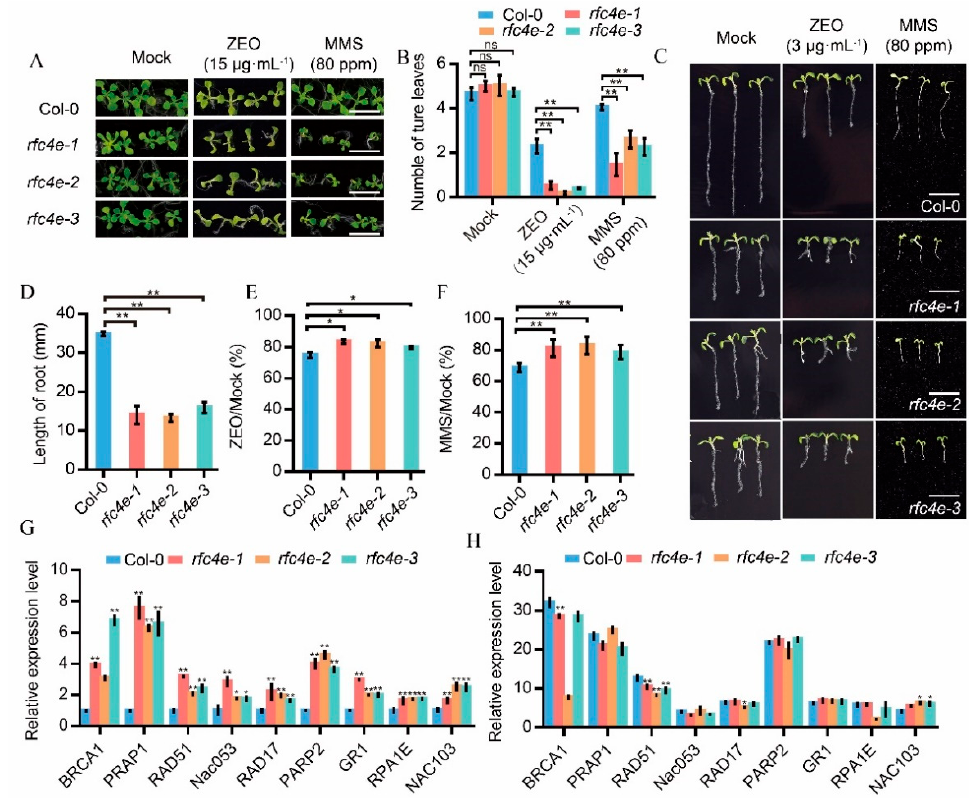
Figure 5. The rfc4e mutants were sensitive to DNA damage agents and constitutively expressed DNA repair-related genes. ( A ) The 12 − d − old seedling of rfc4e − 1 , rfc4e − 2, rfc4e − 3 and Col − 0 grown on ½ MS medium containing 80 ppm MMS or 15 μ g·mL − 1 Zeocin. Mock, treatment without MMS and Zeocin used as control. Bar = 1 cm. ( B ) Average numbers of true leaves of the indicated genotypes in ( A ). Error bars indicate ± SD, n = 39. ( C ) Roots of rfc4e − 1 , rfc4e − 2, rfc4e − 3 and Col − 0 vertically grown on ½ MS medium containing 80 ppm MMS or 3 μ g·mL − 1 Zeocin for 7 days. Mock, treatment without MMS and Zeocin used as control. Bar = 1 cm. ( D ) Root length of the indicated genotypes in ( C ), n > 20. ( E , F ) Relative root growth rate of Col − 0 and rfc4e mutants grown on medium containing 15 μ g·mL − 1 Zeocin ( E ), or 80 ppm MMS ( F ). Mock, treatment without MMS and Zeocin used as control. ( G , H ) DDR gene expression levels in Col − 0 and rfc4e mutants treated without ( G ) and with ( H ) Zeocin. ( G ) Relative expression of genes in 12 − d − old plants of the indicated genotypes under standard conditions, as determined by RT - qPCR. Data were normalized to the value of Col − 0. ( H ) Relative expression of genes in 12 − d − old plants of the indicated genotypes after 2 h of 100 μ g·mL − 1 Zeocin treatment, as determined by RT-qPCR. Data were normalized to the value of the same genotype under standard conditions. The experiment was repeated twice with similar results. Error bars indicate ± SD (* p < 0.05; ** p < 0.01), ns represents no significance.